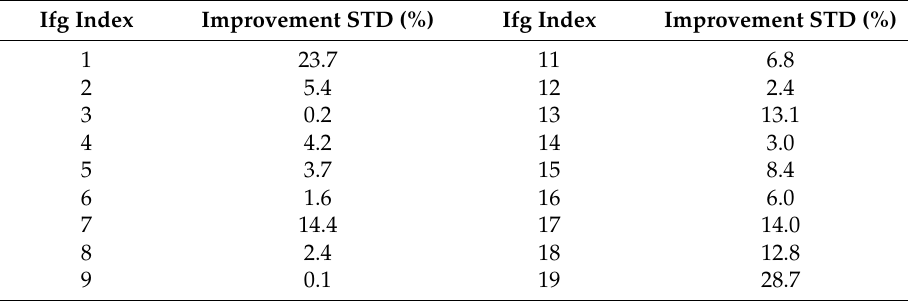
Table 3. Improvement of standard deviation (STD) by the robust